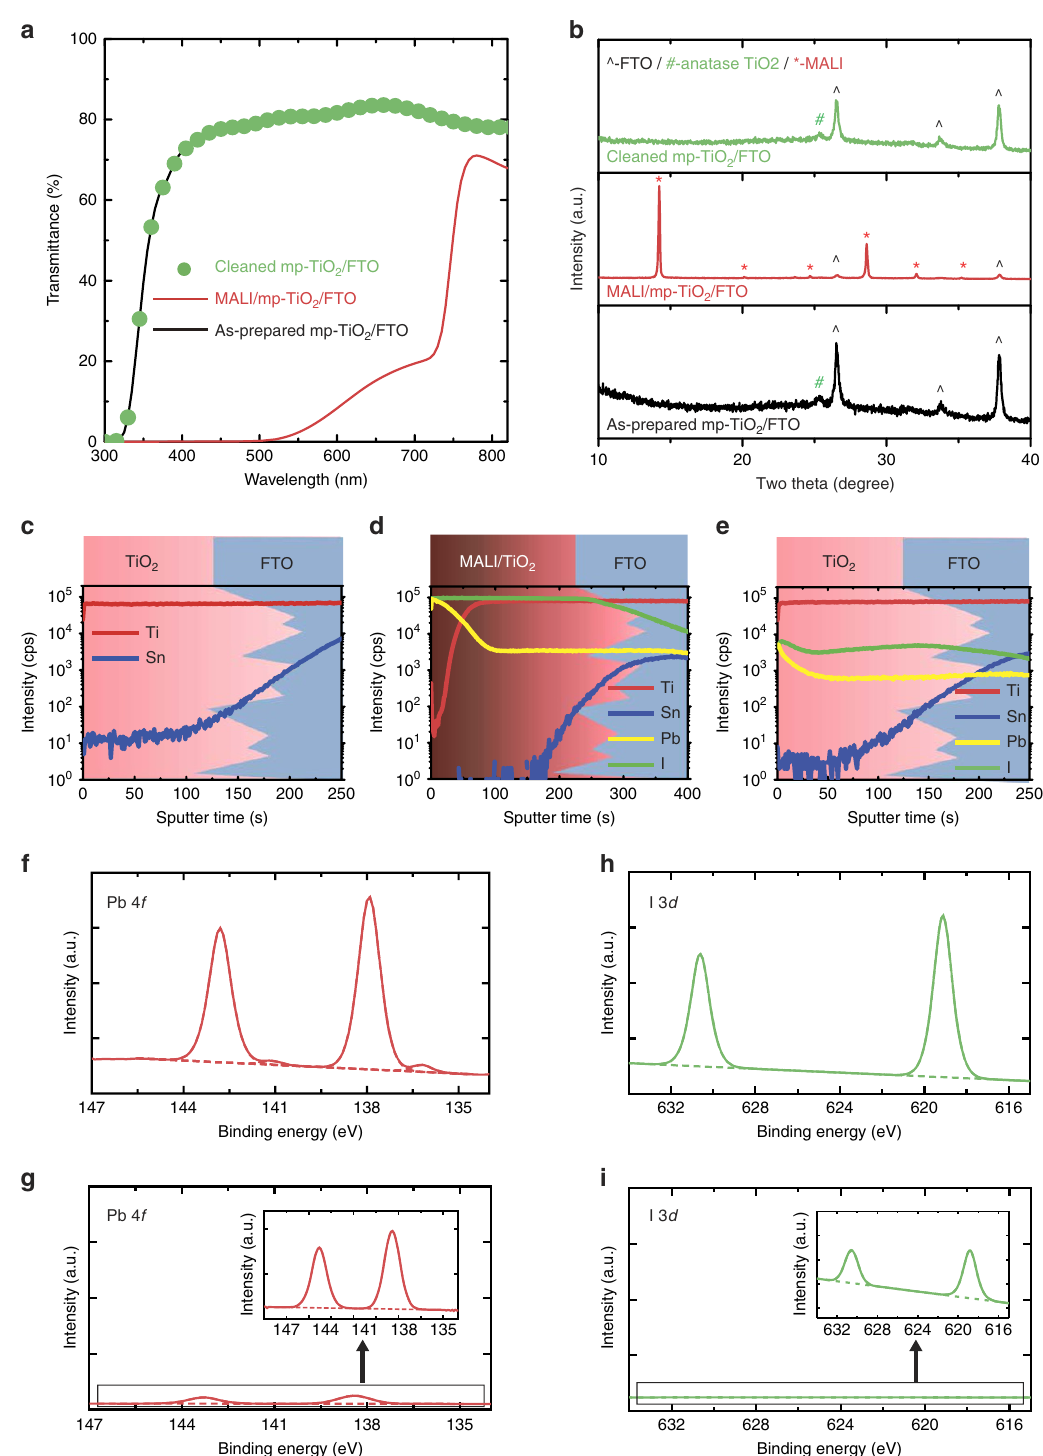
Figure 5 | Optical and surface analysis before/after selective dissolution of the substrate. After the recycling process using a polar aprotic solvent, ( a ) the optical transmittance is preserved and ( b ) the X-ray diffraction patterns of the cleaned mp-TiO 2 /FTO substrate exhibit peaks corresponding to anatase TiO 2 and FTO without MALI or PbI 2 (^ with black: FTO, # with green: anatase TiO 2 , * with red: MALI). Results of secondary ion mass spectroscopy performed on ( c ) as-prepared mp-TiO 2 /FTO, ( d ) MALI/mp-TiO 2 /FTO and ( e ) cleaned mp-TiO 2 /FTO. The background schematics of the spectra represent the device structure; thus, the initial values of the spectra at 0s of sputtering time represent each ion concentration at the surface of each substrate. The results for the cleaned mp-TiO 2 /FTO substrate reveal the presence of residual Pb 2 þ and I - ions on the cleaned substrate. X-ray photoemission spectra of ( f , g ) Pb 4 f and ( h , i ) I 3 d on the substrate before and after selective dissolution, respectively. The binding energies of Pb 4 f and I 3 d correspond to Pb and I in the perovskite layer and in the form of residual PbI 2 on the mp-TiO 2 /FTO and cleaned mp-TiO 2 /FTO substrates,